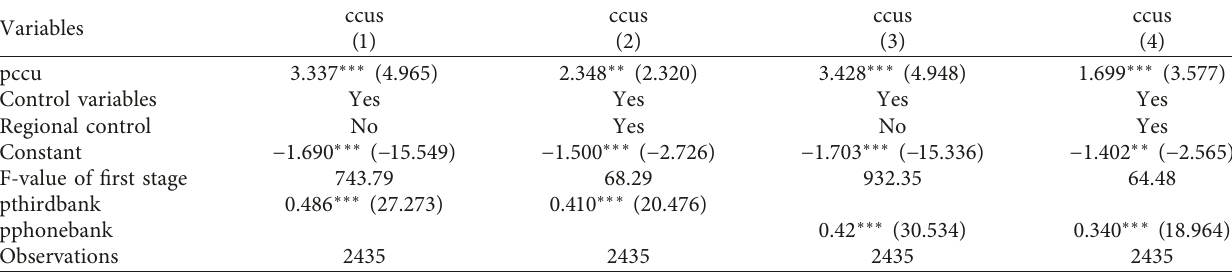
Table 4: Instrumental variable estimation results of the peer effects of